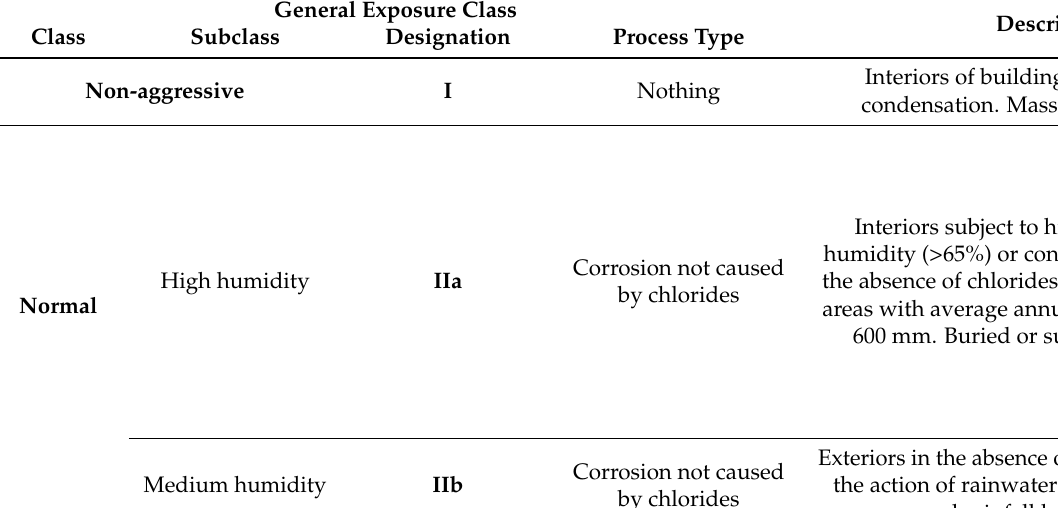
Table 1. General exposure classes related to rebar